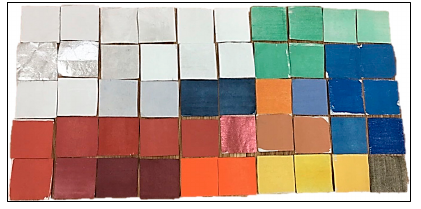
Figure 3. The sample blocks of glued pigments.